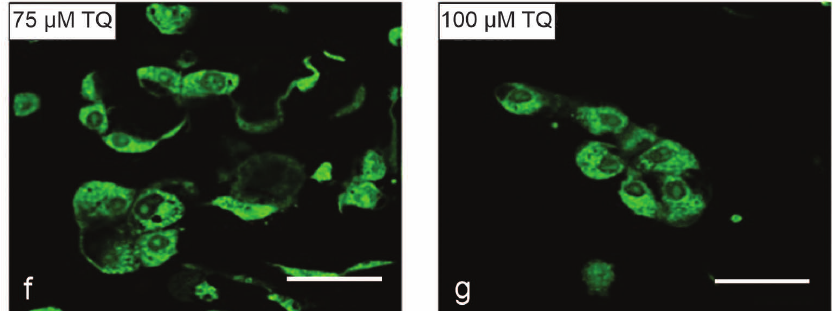
Figure 10. MMP disruption in HuCCT1 cells following exposure to TQ for 24 h (scale bar: 25 µm) MMP was evaluated using JC-1 by image techniques in the cancer cells after being exposed to 0–100 µM TQ: 0 µM TQ ( a ) and DMSO ( b ), and 10 ( c ), 25 ( d ), 50 ( e ), 75 ( f ), and 100 µM ( g ) TQ. The best representative images of each group are shown.